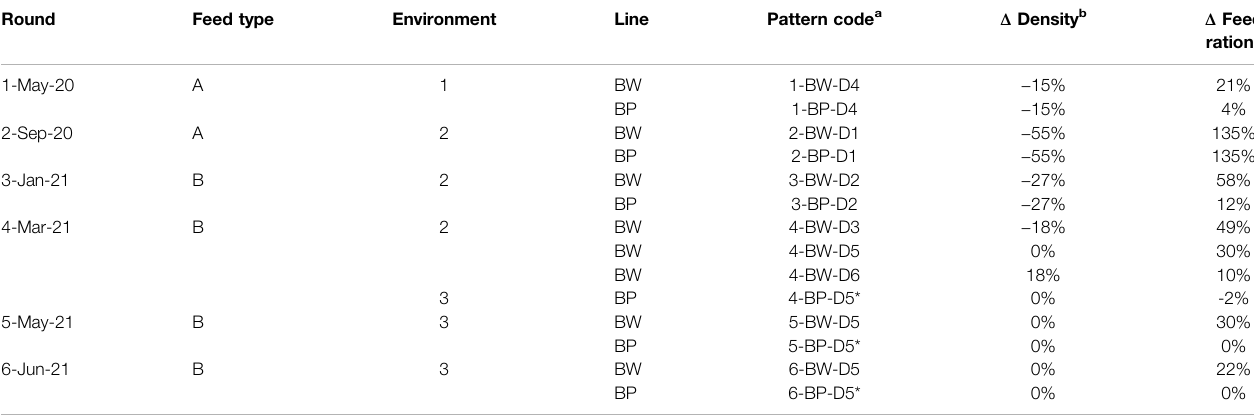
TABLE 1 | Summary of the experimental